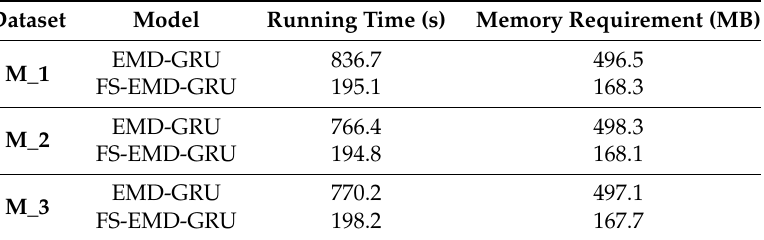
Table 4. Comparison of the running time and memory space requirements of the EMD-GRU model and the FS-EMD-GRU model.